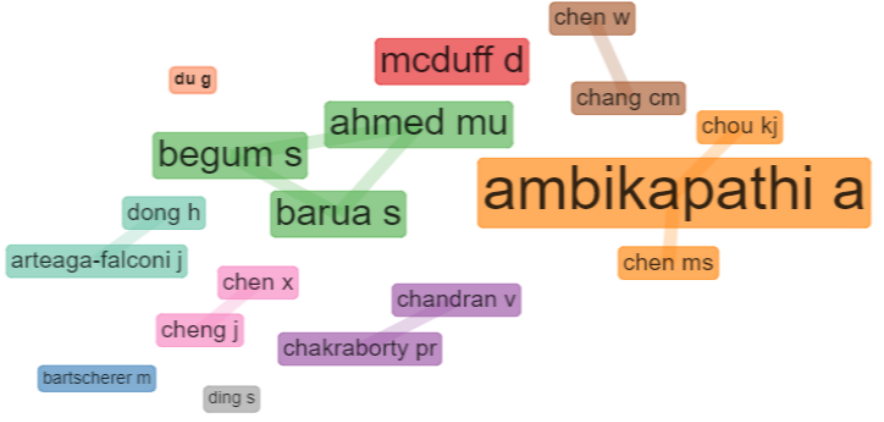
Figure 6. Collaboration